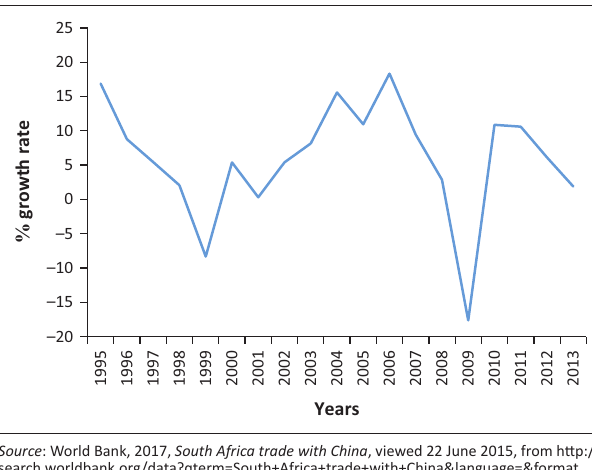
FIGURE 2: Percentage growth of South Africa exports to China. FIGURE 3: Percentage growth of South Africa imports from China.